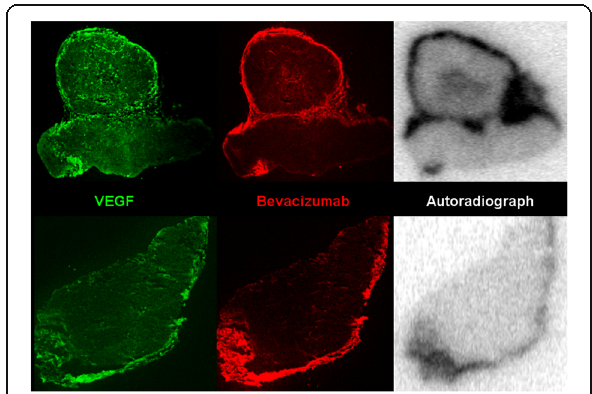
Fig. 4 Comparison of the distribution of VEGF, bevacizumab, and 111 In in FaDu xenograft sections. The rows are examples of two sections from different FaDu xenografts injected with 111 In-bevacizumab and an excess of unlabelled bevacizumab at 5 days. The left panels ( green ) are immunofluorescence images of VEGF staining, the centre panels ( red ) are immunofluorescence images of bevacizumab staining, and the right panels ( grayscale ) are autoradiographs of 111 In